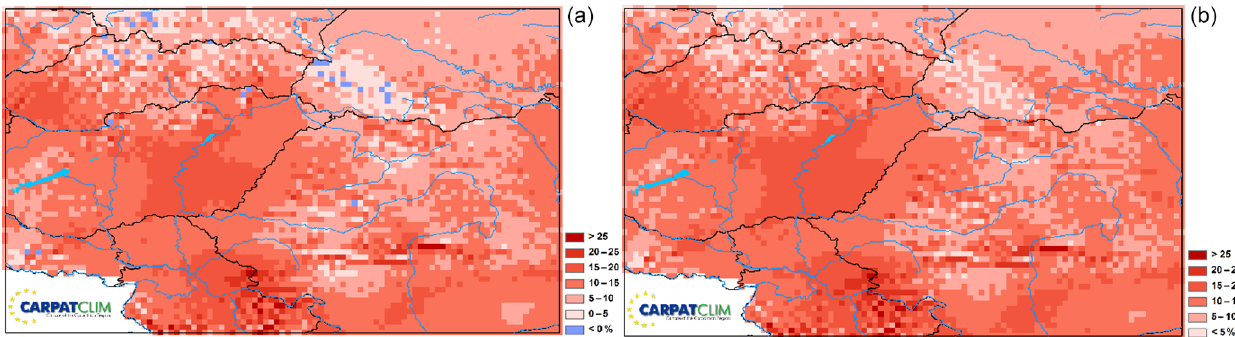
Figure 3. Annual relative bias (%) (a) and RMSE (%) (b) of Thornthwaite estimates (PET_Th) compared with Penman–Monteith ET 0 over the CarpatClim region for the period 1961–2010.